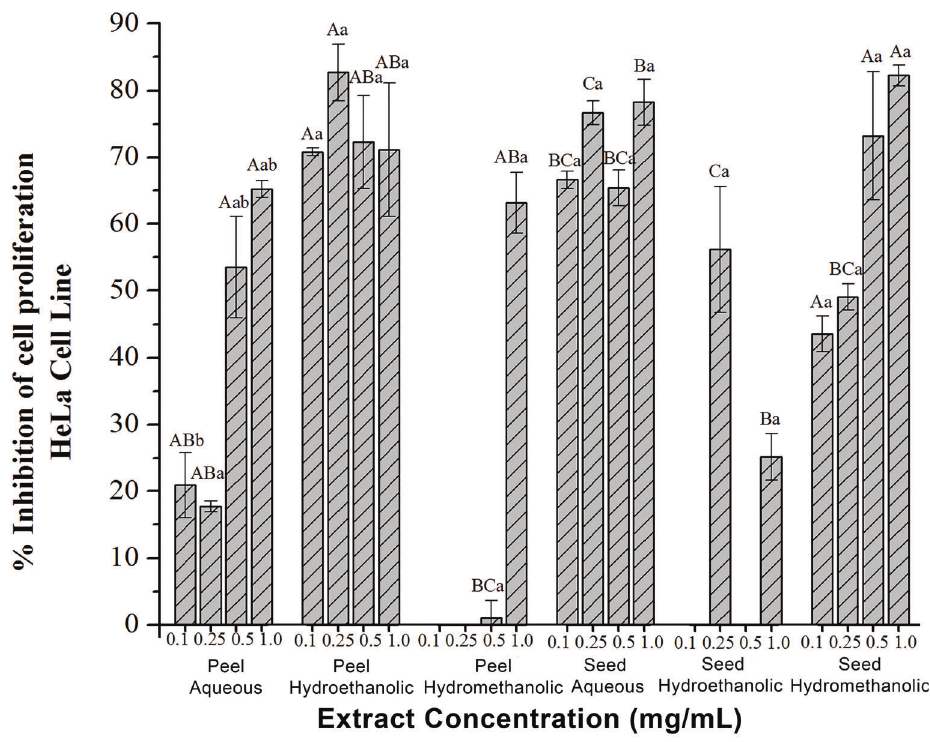
Figure 6. Effect of melon residues extracts on the inhibition of cell proliferation of the HeLa cell line, measured by MTT test. Cells proliferation was carry out in the presence of melon residues extracts in different concentrations for 24 h. a,b,c,d Signi fi cant differences between different concentrations of the same sample. A,B,C,D Signi fi cant differences between different extracts in the same concentration (P o 0.05, ANOVA). Data are reported as means ±